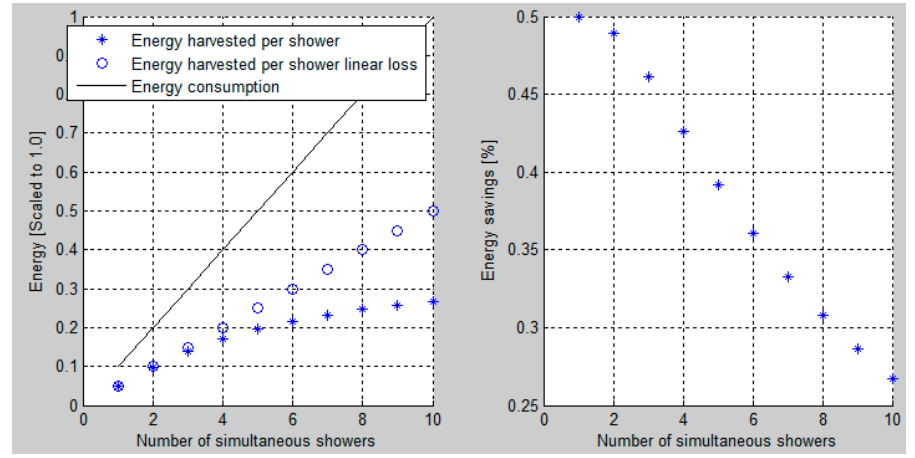
Figure 8. Scaled energy usage and savings in the case of multi simultaneous showers.